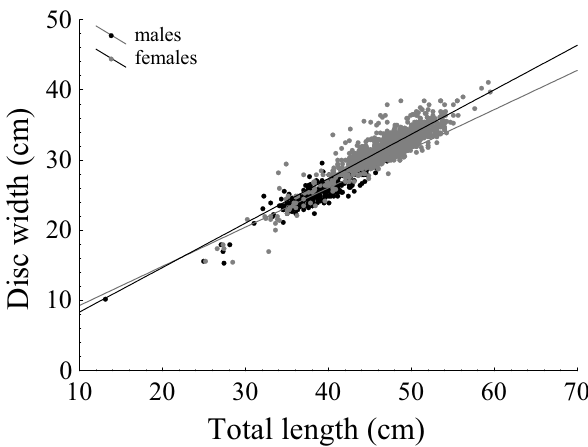
Fig. 3. Absolute frequency of total length (cm) for males (full line) and females (dotted line) for grouped samples of Rioraja